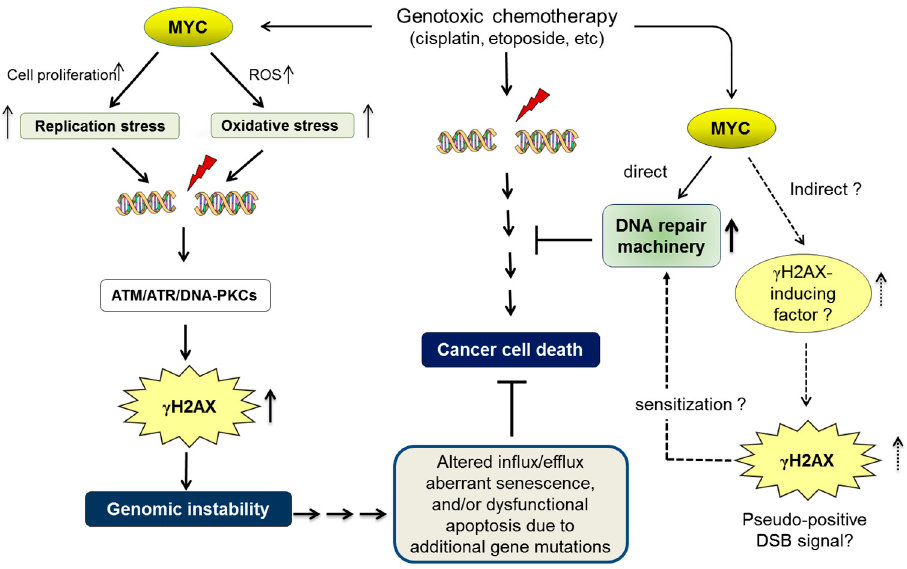
Figure 1. MYC induces genomic instability and chemoresistance.